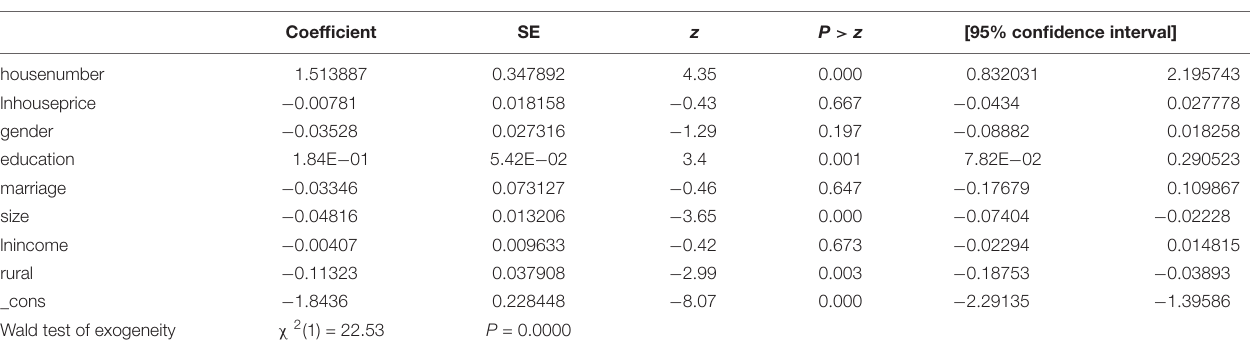
TABLE 5 | Regression results of the second stage of ivprobit estimation.